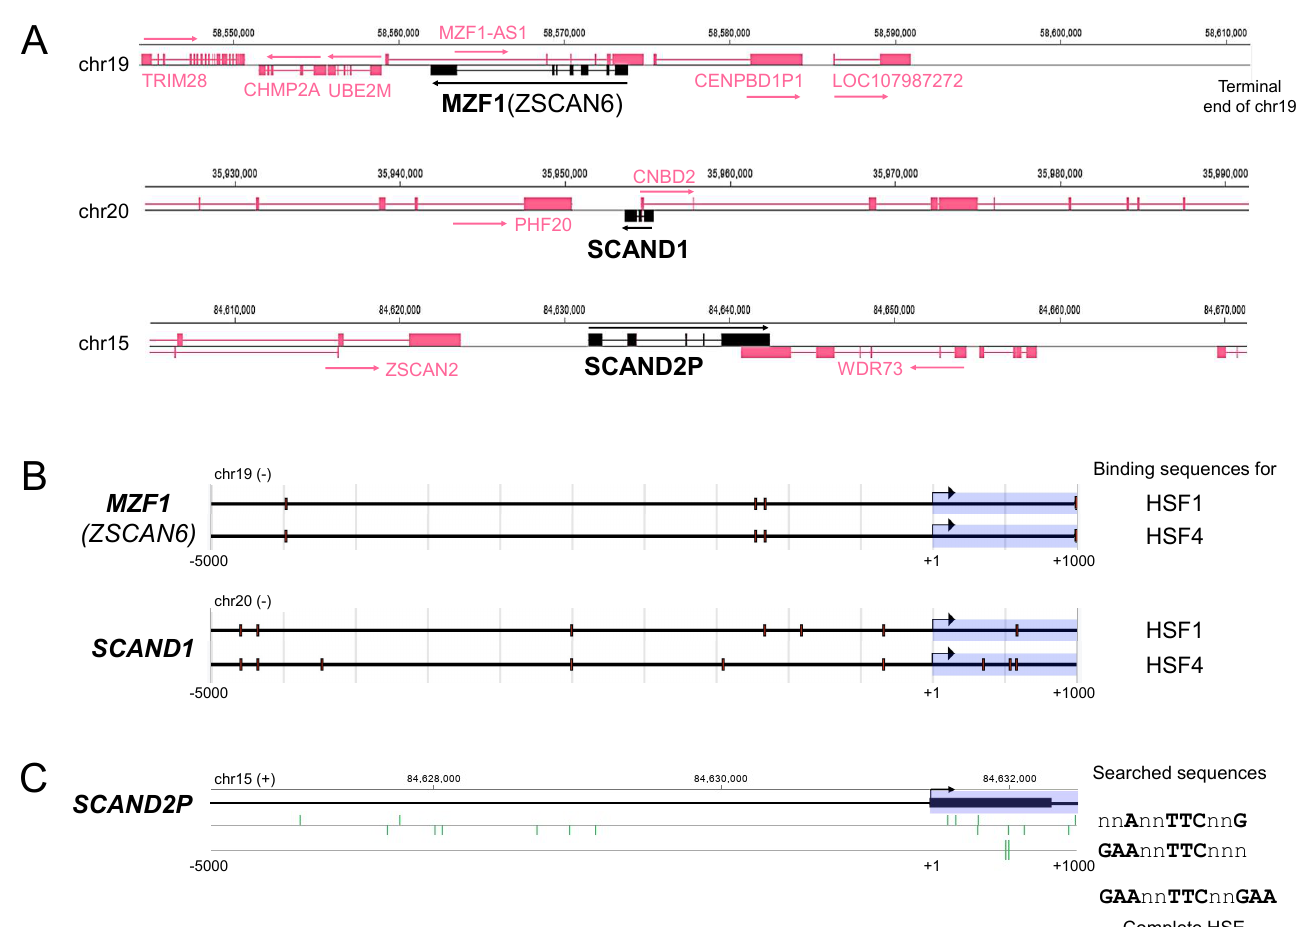
Figure 1. Gentic loci of MZF1(ZSCAN6), SCAND1 , and SCAND2P in the human genome. ( A ) Locations and structures of MZF1, SCAND1 , and SCAND2P genes on human chromosomes (hg38). ( B , C ) Mapping of heat shock elements (HSEs) in the promoter regions ( − 5000 to +1000) of ( B ) MZF1 , SCAND1 , and ( C ) SCAND2P genes. To predict whether MZF1, SCAND1 , and SCAND2P genes are transcriptionally reg- ulated by HSFs and MZF1, we searched for binding sequences of these TFs in promoter regions. Several binding sequences (BSs) for HSF1 and HSF4 were found in the promoter regions of MZF1, SCAND1 , and SCAND2P genes (Figure 1B,C; Table 1). Moreover, dozens of MZF1-BSs were found in the promoter regions of SCAND1 and MZF1 genes (Table